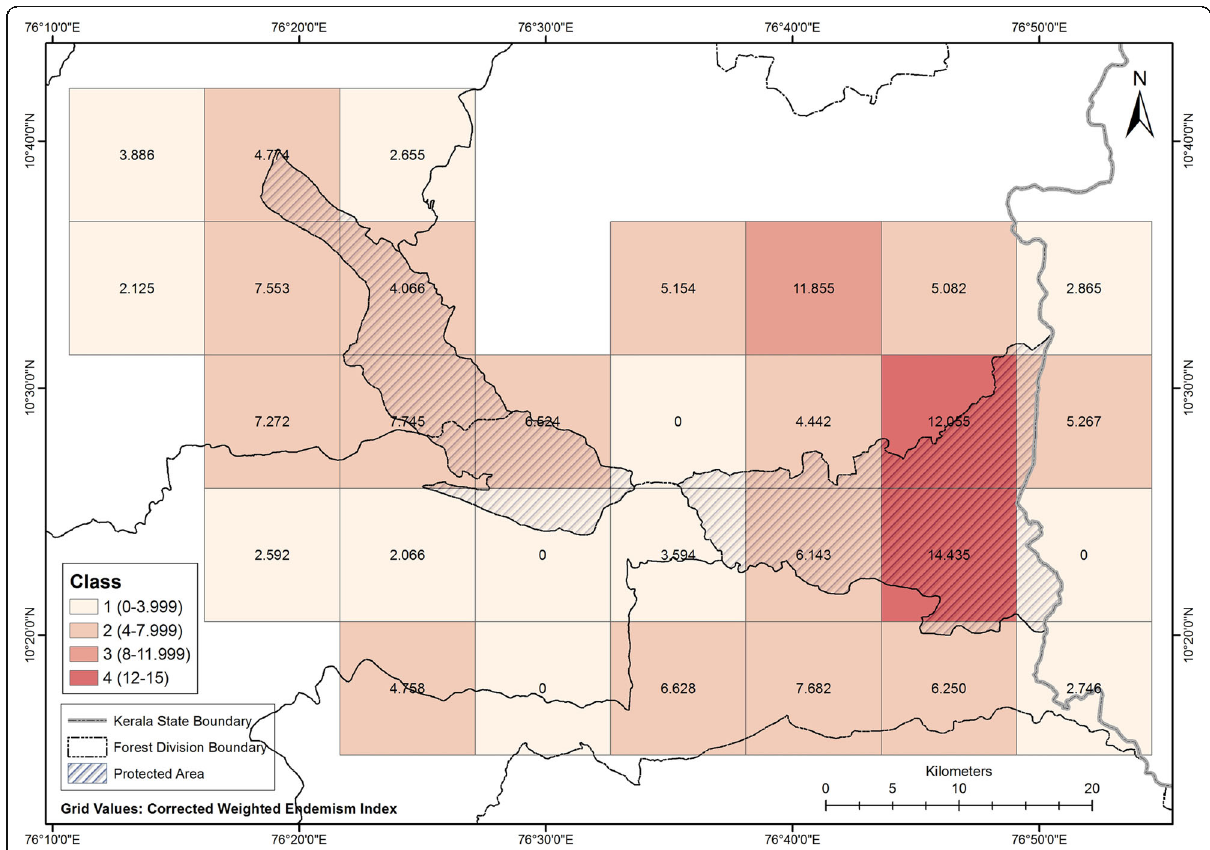
Fig. 8 Corrected weighted endemism index values of the grids within study